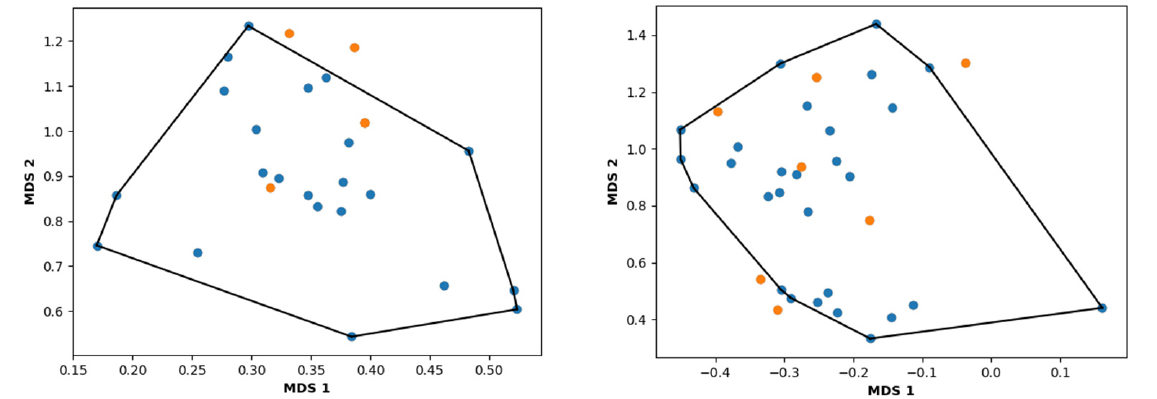
Figure 5. Applicability domain for group G 1 ( left ) and group G 2 ( right ). The molecules of the train- ing set are illustrated in blue, and the compounds of the test set are depicted in orange.